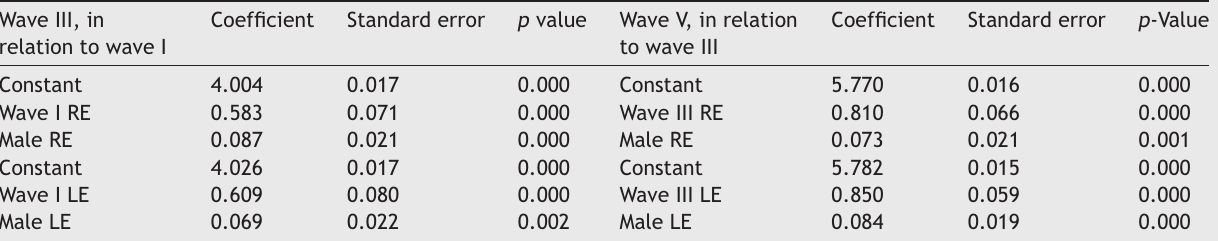
Table 2 Results of the final linear regression model measuring the brainstem auditory evoked potential (absolute latency of waves III and V), right and left ears, for males compared to